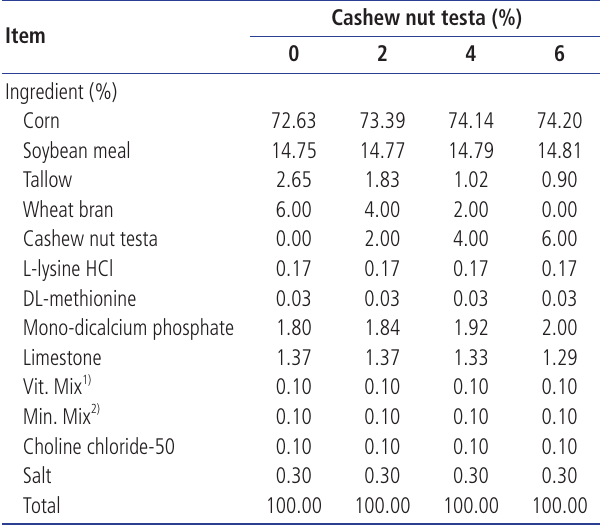
Table 1. Formulation of experimental diets for gestating sow Item